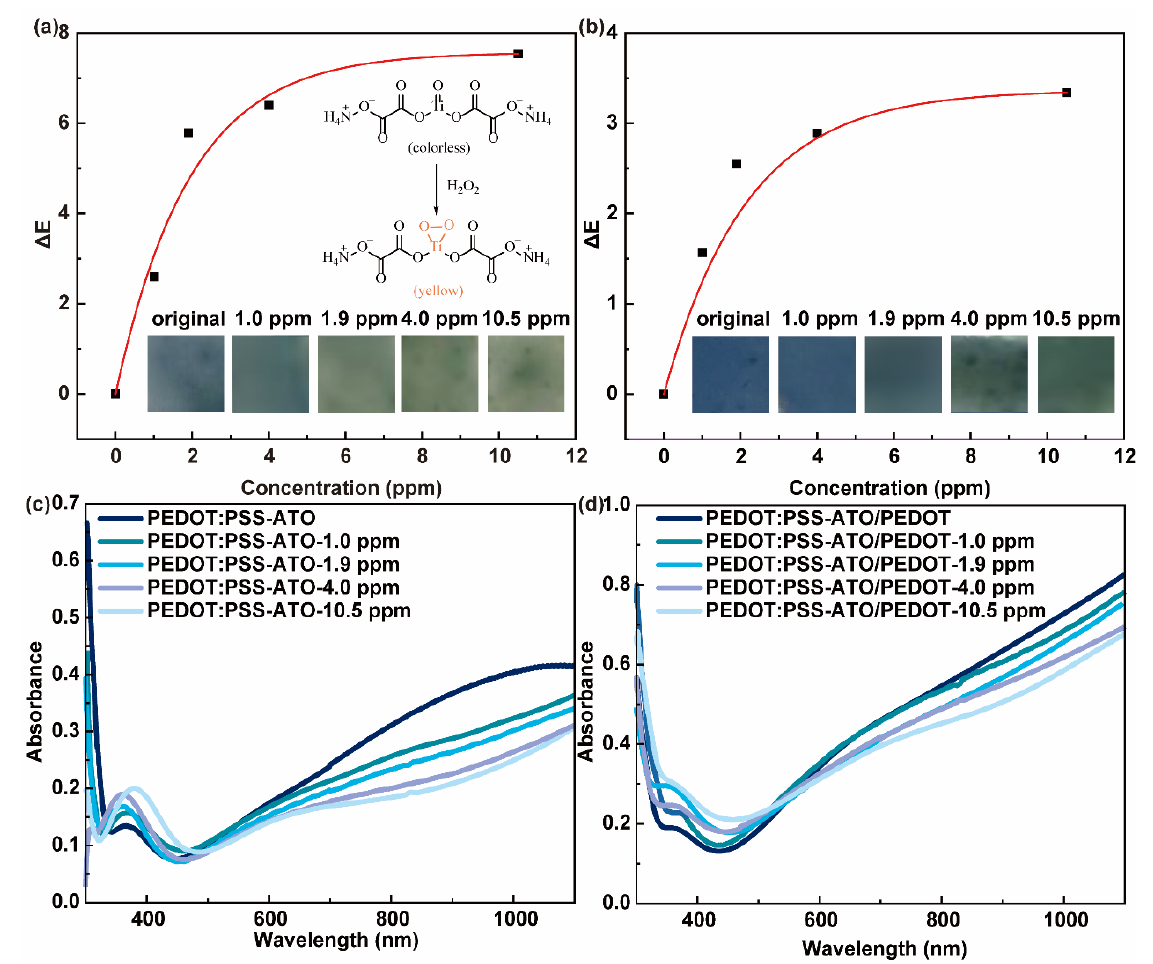
Figure 5. Colorimetric response–HPV concentration fitting curves of ( a ) PEDOT:PSS-ATO and ( b ) PEDOT:PSS-ATO/PEDOT films (inset: mechanism of the discoloration of ATO to H 2 O 2 through oxidation, showing photos of the film before and after exposure to different concentrations of HPV). UV-visible absorption spectra of the original ( c ) PEDOT:PSS-ATO and ( d ) PEDOT:PSS-ATO/PEDOT films and after the detection of different concentrations of